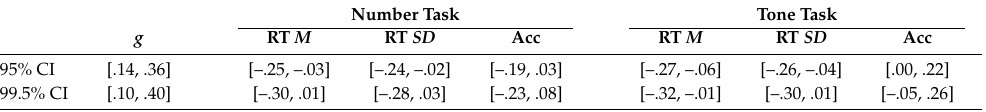
Table 6. Comparison of correlations with Openness versus Intellect using confidence